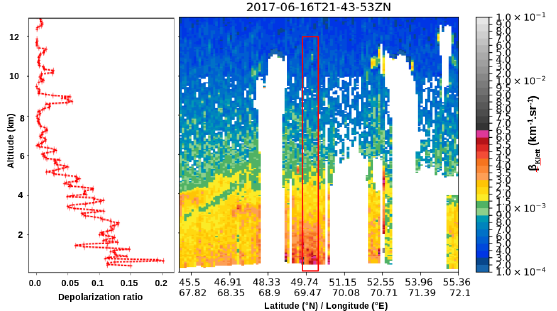
Fig. 4: Vertical cross-section of CALIOP 532 backscatter coefficient (right side) on June 16 in the Kazakhstan source region. CALIOP 532 depolarization ratio vertical profile at 49.74°N (left side).